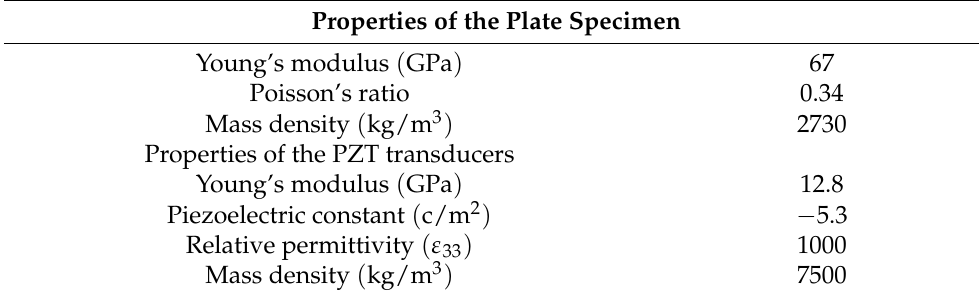
Table 1. Material properties of plate specimen and PZT